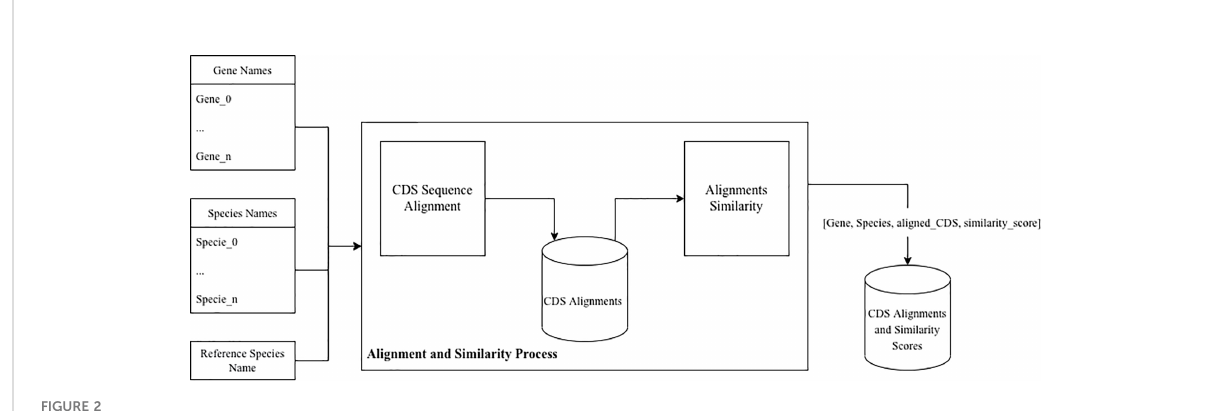
FIGURE 2 Data processing pipeline.